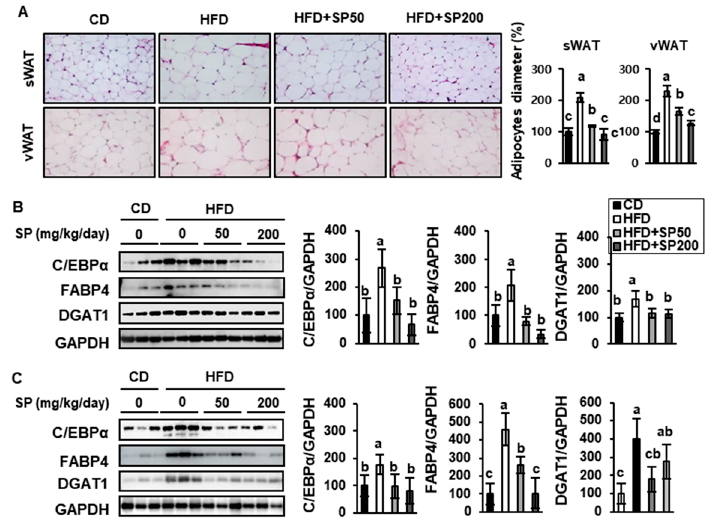
Figure 5. Protective e ff ect of silk peptide against lipid accumulation in white adipose tissue from HFD-induced obese mice. ( A ) Hematoxylin and eosin staining of sWAT and vWAT from mice treated for 6 weeks and quantification of relative adipocyte diameter percentage of sWAT and vWAT (data were collected from H&E-stained sections of mice in each group, 15–30 cells per same area, using Image J software). The expression of adipogenic factors in ( B ) sWAT and ( C ) vWAT were assessed by western blotting. Data are expressed as mean ± SD ( n = 8). Values with di ff erent letters were significantly di ff erent; p < 0.05 (a > ab > b > bc >